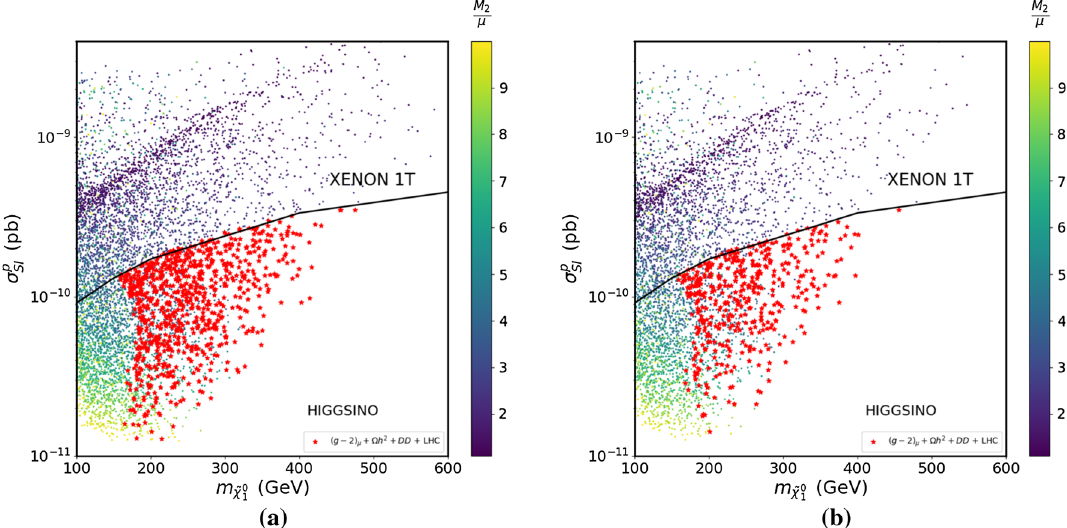
Fig. 3 Scan results in the m ˜ χ 0 – σ SI p plane for higgsino DM scenario 1 for current (left) and anticipated future limits (right) from ( g − 2 ) μ . The color coding of the points denotes M 2 /μ and the black line